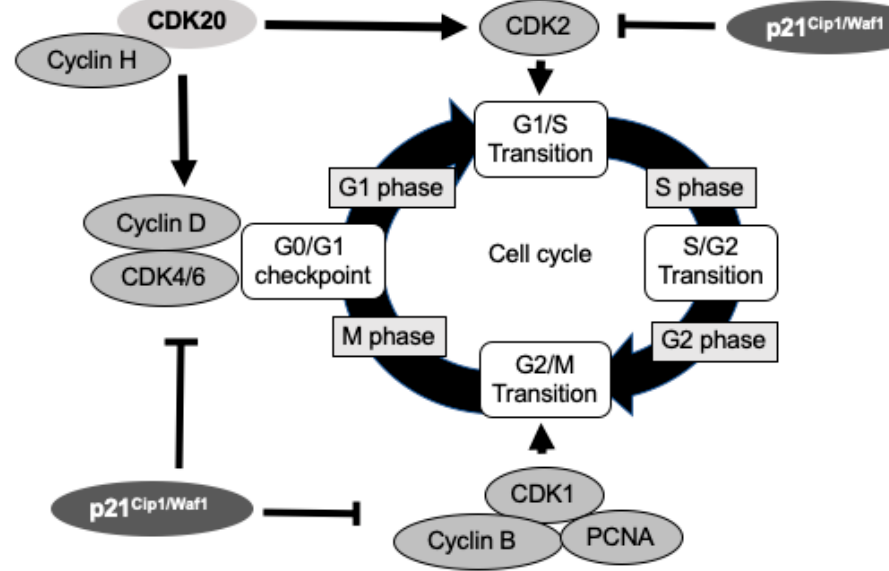
Figure 1. The function of cyclin-dependent kinase (CDK) 20 (CDK20) and p21 Cip1 / Waf1 in cell cycle regulation. CDK20 plays a positive regulation on cell cycles by activating CDK2 and cyclin D, while p21 Cip1 / Waf1 acts as a cell cycle inhibitor to arrest cell cycle by binding to CDK2, CDK4 / 6, CDK1, cyclins, and proliferating cell nuclear antigen (PCNA) .